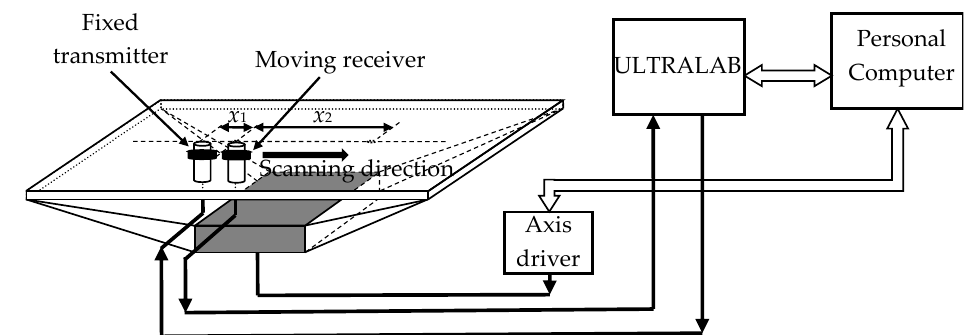
Figure 6. Structural scheme of the Lamb wave S 0 mode signal generation and recording in thin PVC film.